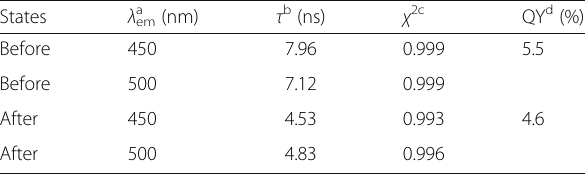
Table 1 Photophysical data for CDs (3.75 μ g mL − 1 in deionized water) before and after 0.5 M H 2 O 2 treatment